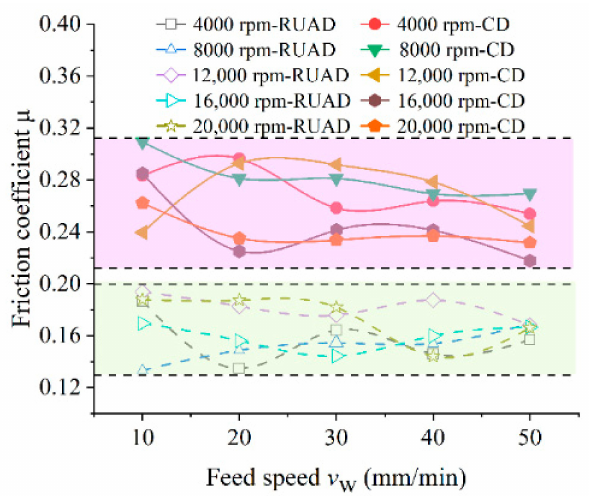
Figure 10. Effect of machining parameters on friction coefficient with and without ultrasonic drilling